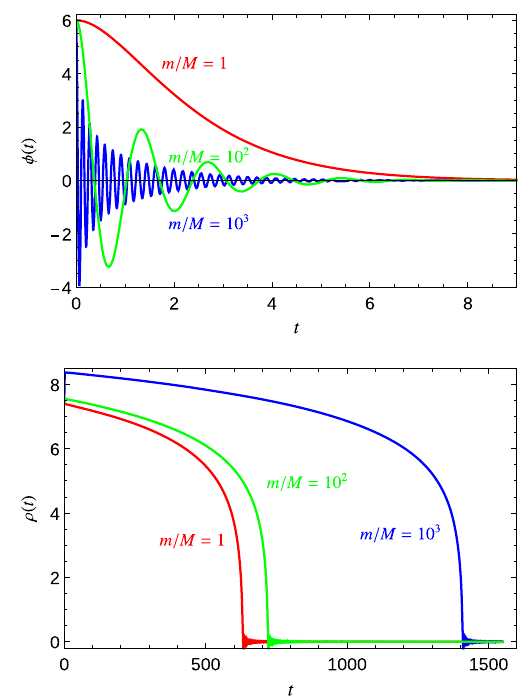
Fig. 7 Top: the field φ( t ) as a function of time for the values of the ratio m / M = 1 , 10 2 , 10 3 . Bottom: the field ρ( t ) as a function of time for the values of the ratio m / M = 1 , 10 2 , 10 3